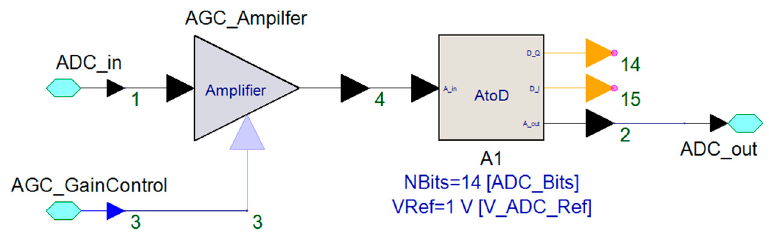
Figure A10. ADC_AGC model.